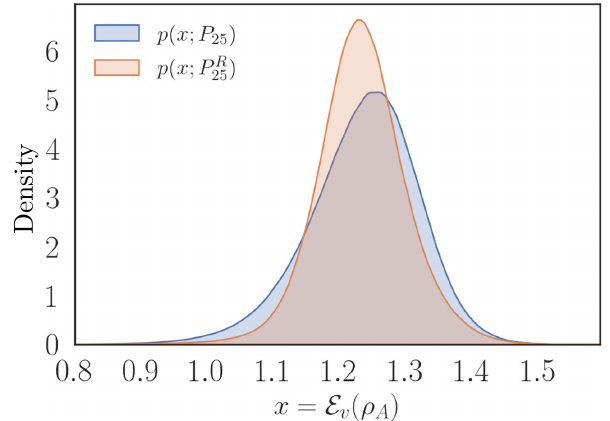
FIG. 13. Case of d 2 = 25. The entanglement distributions of 2-unitary permutation P 25 [see Eq. (83)] and its realignment , which is also a 2-unitary. The distributions are clearly dis- P R 25 tinguishable: p ( x ; P 25 ) (cid:21)= p ( x ; P R P R 25